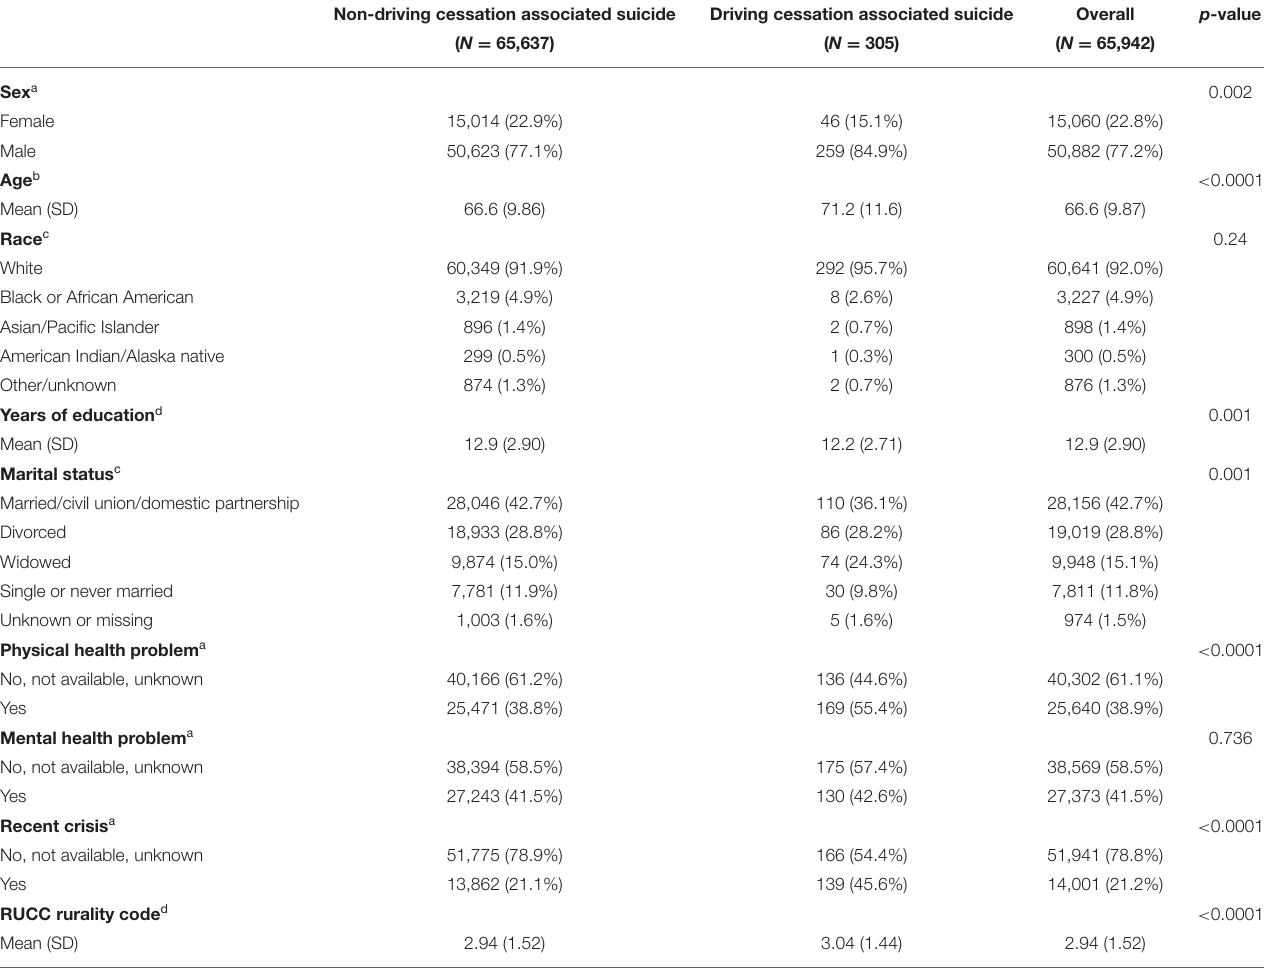
TABLE 1 | Demographic characteristics of decedents of driving cessation associated suicide vs. decedents of non-driving cessation associated suicide. Non-driving cessation associated